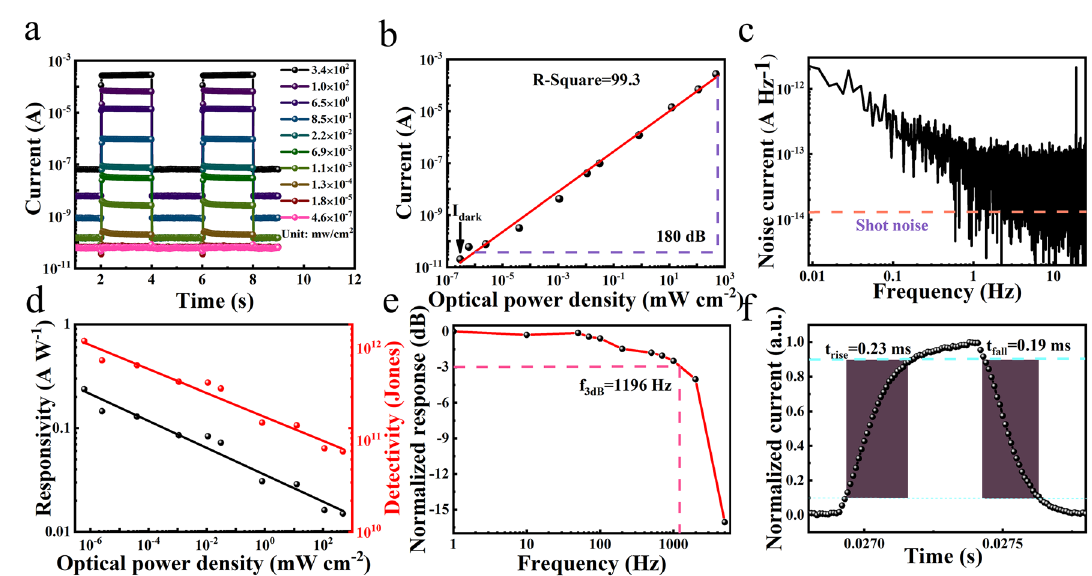
Fig. 4 Device performances of the dual passivated PDs: a current–time curves at different light intensities; b LDR; c noise current curve; d responsivity and detectability versus light intensity curves; e f -3 dB bandwidth; f response/recovery time. All curves are measured at 0